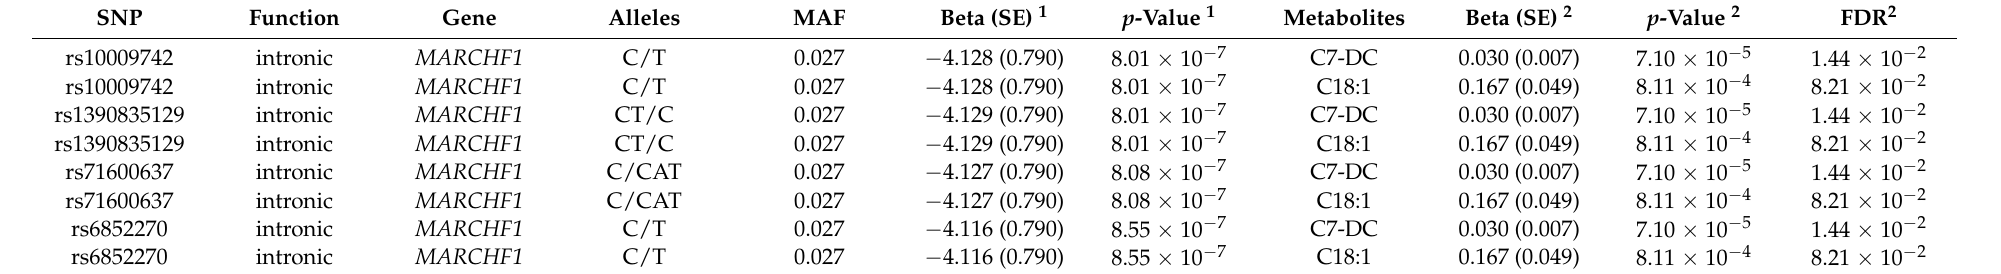
Table 3. Genome–metabolomics integrative analysis for rapid eGFR